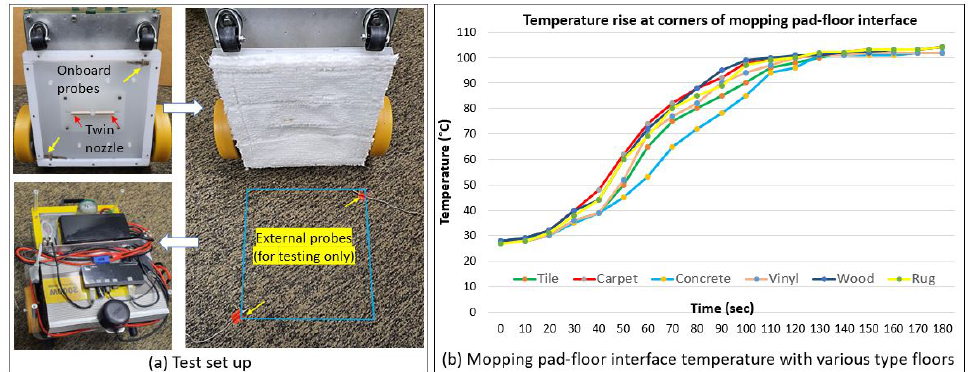
Figure 9. Rise in temperature at corners of pad–floor interface for various floors.